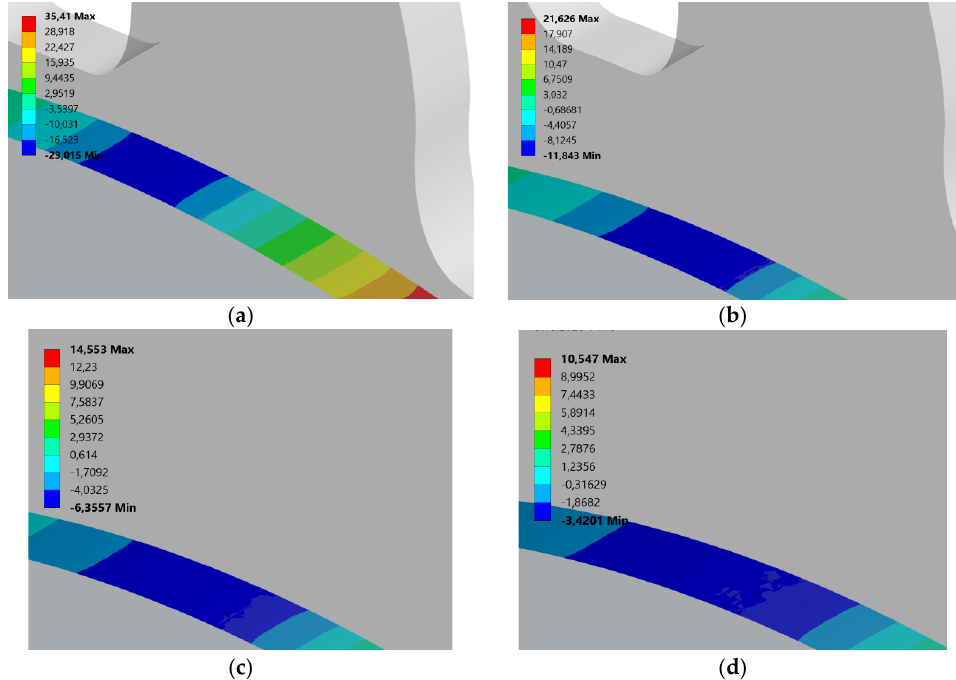
Figure 11. Normal stress results for hybrid gears generated rack tip radius, ρ 1 = 0.1 xm for different